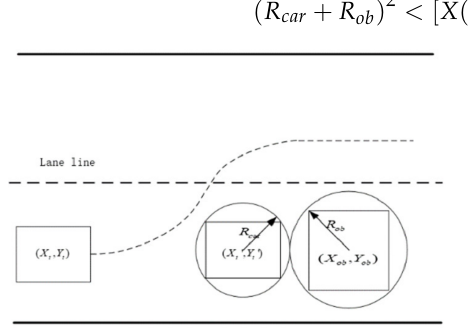
Figure 2. Schematic diagram of collision avoidance. Adding the anti-rollover condition constraint